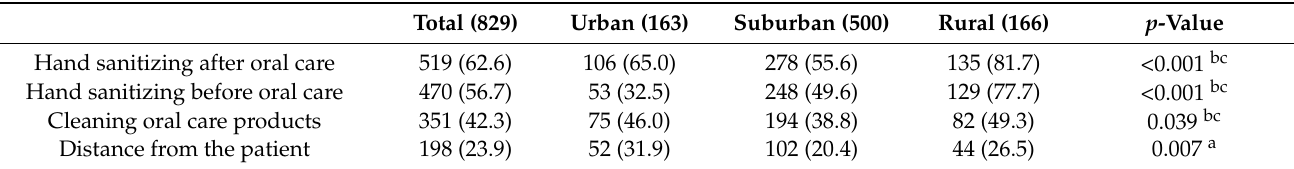
Table 5. Increased infection control measures in oral health care after the start of the pandemic (N, %)